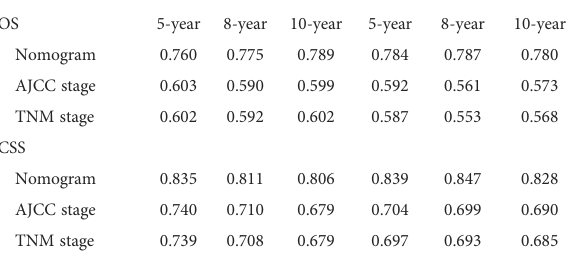
TABLE 5 Comparison of area under the curve (AUC) between the nomogram, TNM, and AJCC stages in chromophobe renal cell carcinoma patients.